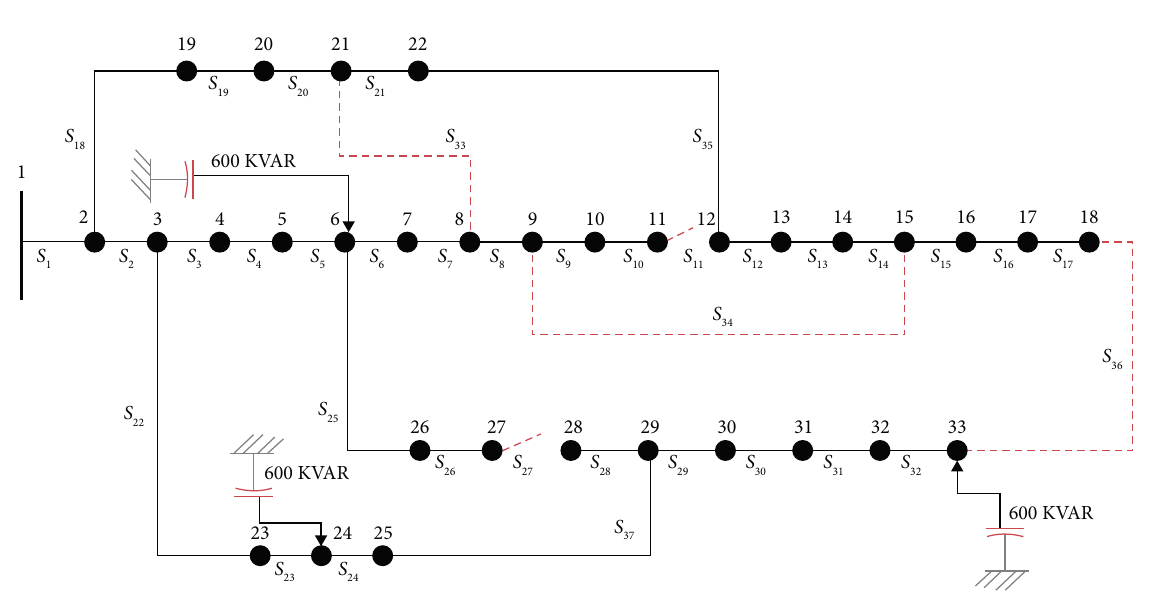
Figure 7: 33-bus IEEE system for scenario